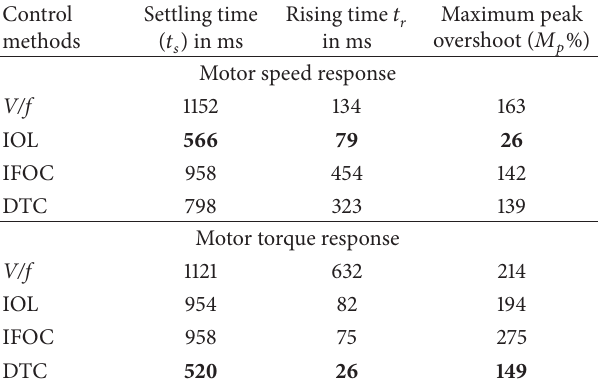
Figure 17: Experimental result of torque-speed response of DTC control method. Table 2: Transient response results for step change in speed reference command.